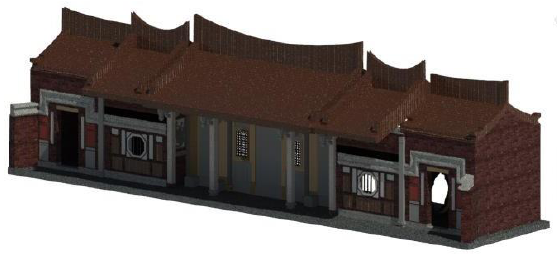
Figure 8. The front gate of Huangxi academy.